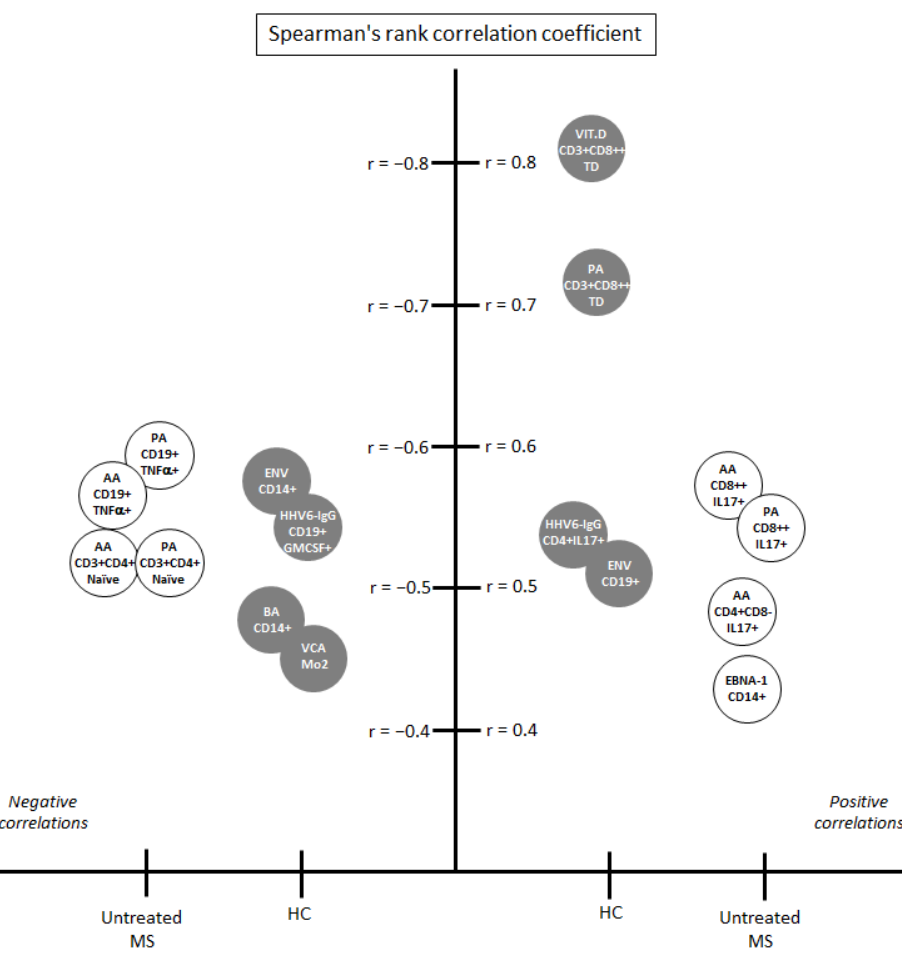
Figure 3. Main correlations among environmental factors and cell subsets: only those with p < 0.01 (Mann–Whitney U-test) and Spearman’s rank correlation coefficient (r) above 0.4 or below − 0.4 are shown. Gray circles: correlations in HC group; white circles: correlations in MS group.